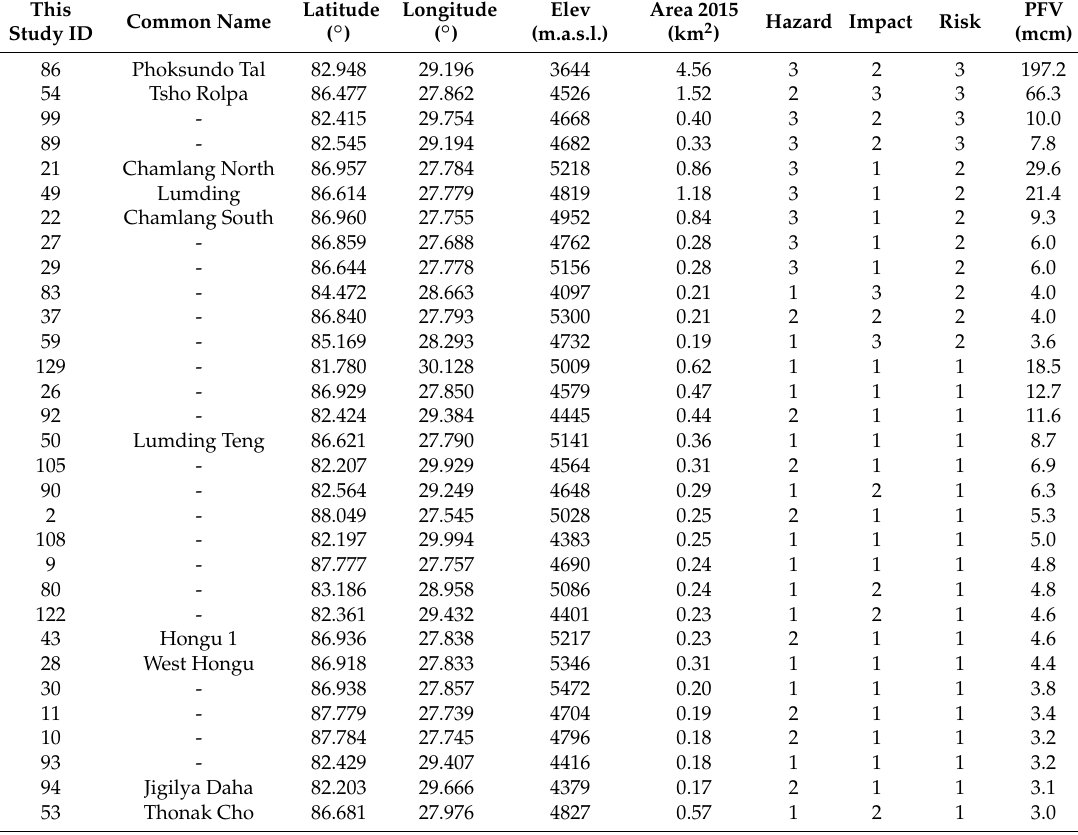
Table 3. Prioritized list of lakes with highest risk with a minimum PFV of 3 mcm (lines denote the different levels of risk). Hazard, downstream impact, and risk classification values refer to low (0); moderate (1); high (2); and very high